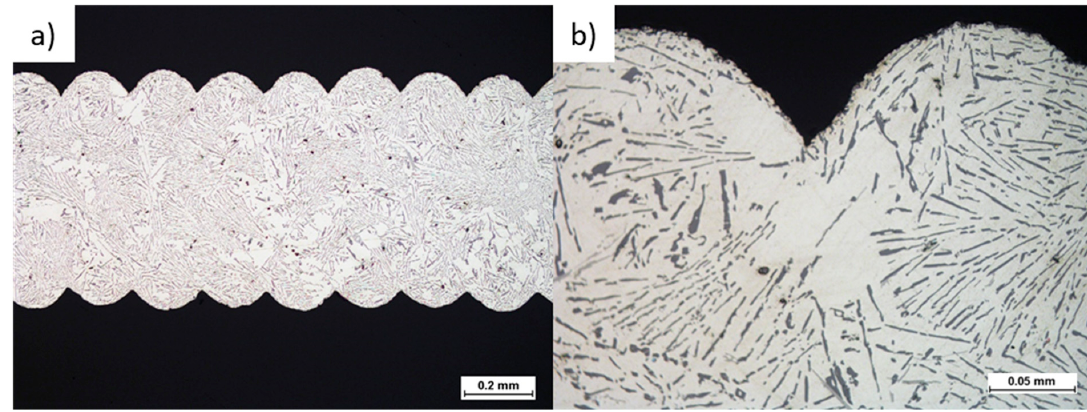
Figure 2. Cast Al–Si honeycomb structures: ( a ) solid, ( b ) perforated.